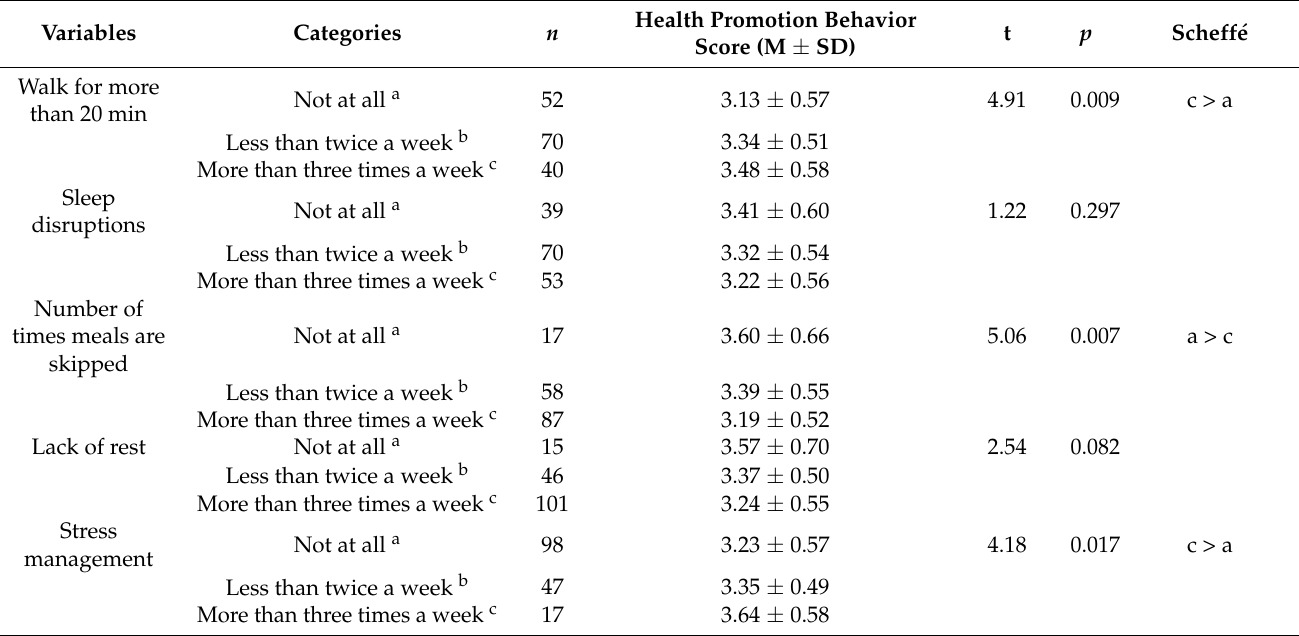
Table 2. Lifestyle Characteristics of the Participants (N = 162).